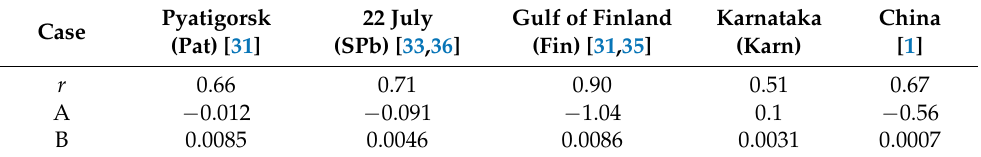
Table 2. Correlation coefficients and constants for the equations relating low frequency flashes to changes in the 35 dBZ cloud volumes, for cloud groupings. In each case, f LF = A + B * dV35. The abbreviations shown for each cloud group are those used in Figure